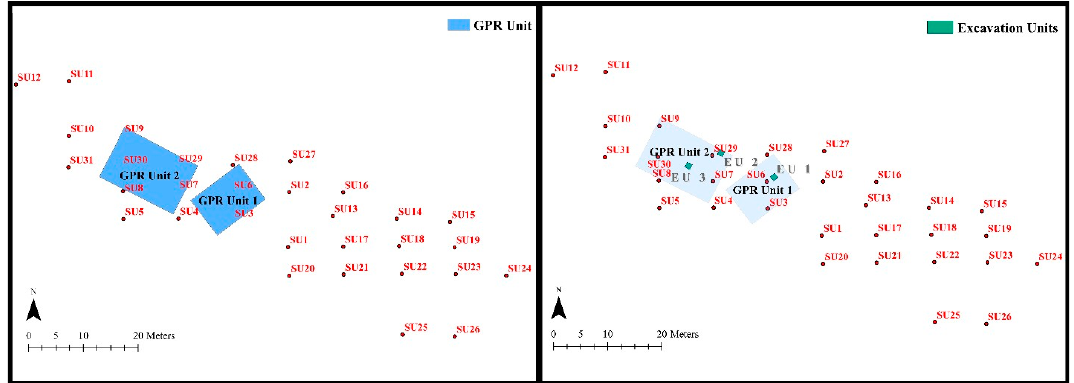
Figure 3. Approximate locations of the ground-penetrating radar (GPR) grids 1 and 2 and excavation units (EU) 1–3.